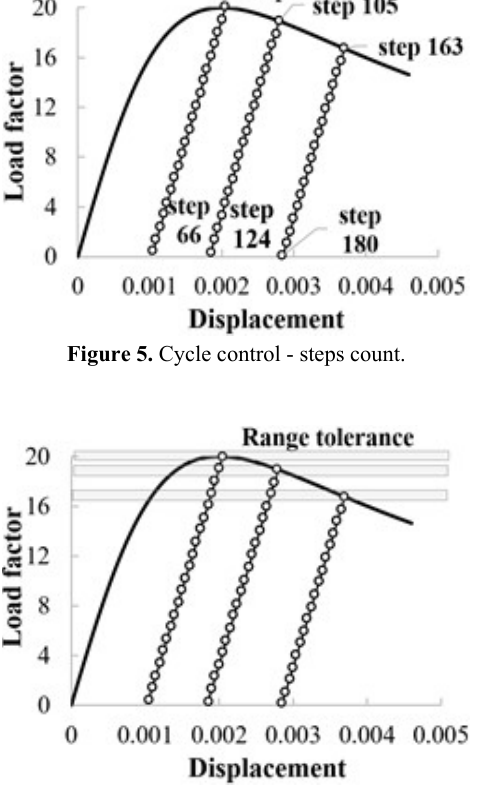
Figure 6. Cycle control - load